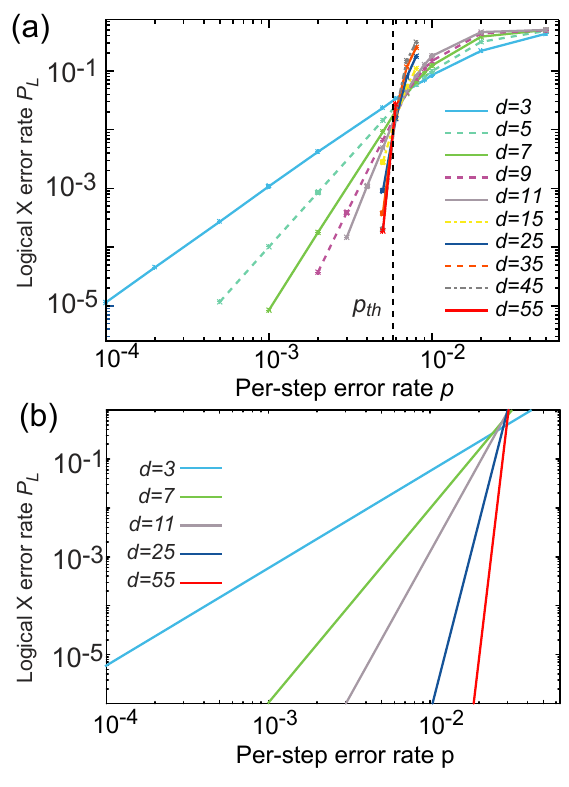
Figure 22: (a) Surface code logical error rate P as a function of per-step error rate p , for L different distance d square arrays. Per-step error rates p that are below the threshold error = 0.57% (dashed line) yield surface code logical error rates P rate p that scale roughly as L th p d . The threshold corresponds to roughly a 0.0057 × 8 ≈ 4% error rate for the entire surface code measurement cycle. (b) Estimated error rates, using statistical arguments given in main text, for array distances d = 3, 7, 11, 25 and 55. Simple estimate is qualitatively similar to detailed simulations. Figure from Ref. (Fowler, Mariantoni, Martinis and Cleland,